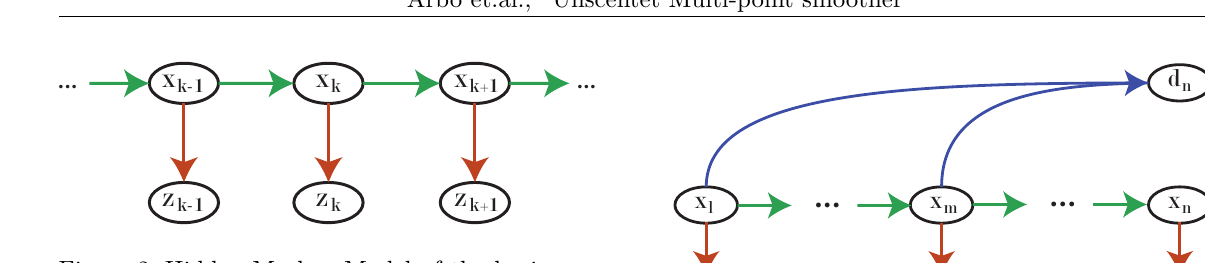
Figure 2: Hidden Markov Model of the basic sys- tem (1)-(2) with state vector x , and measurement vector z . Green arrows represent (1) and red represent (2). Figure 3: Hidden Markov model showing a de-